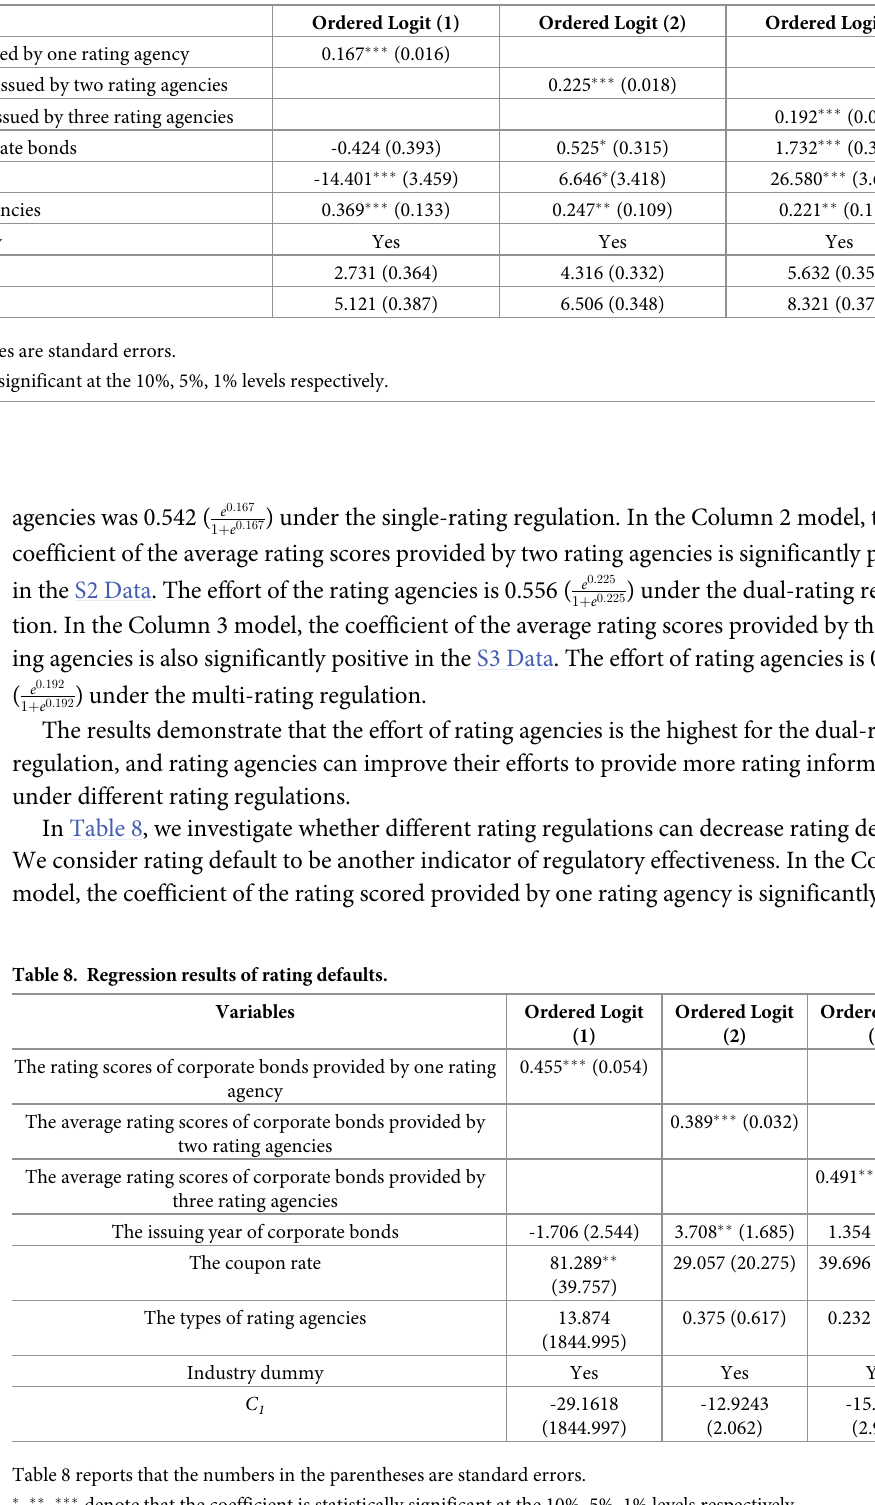
Table 7. Regression results of effort of rating agencies.